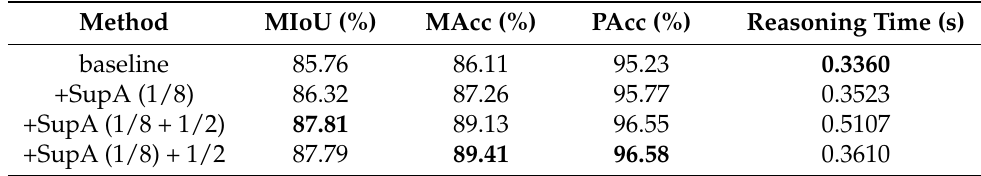
Table 1. Pixel-level decoder ablation experiment results.